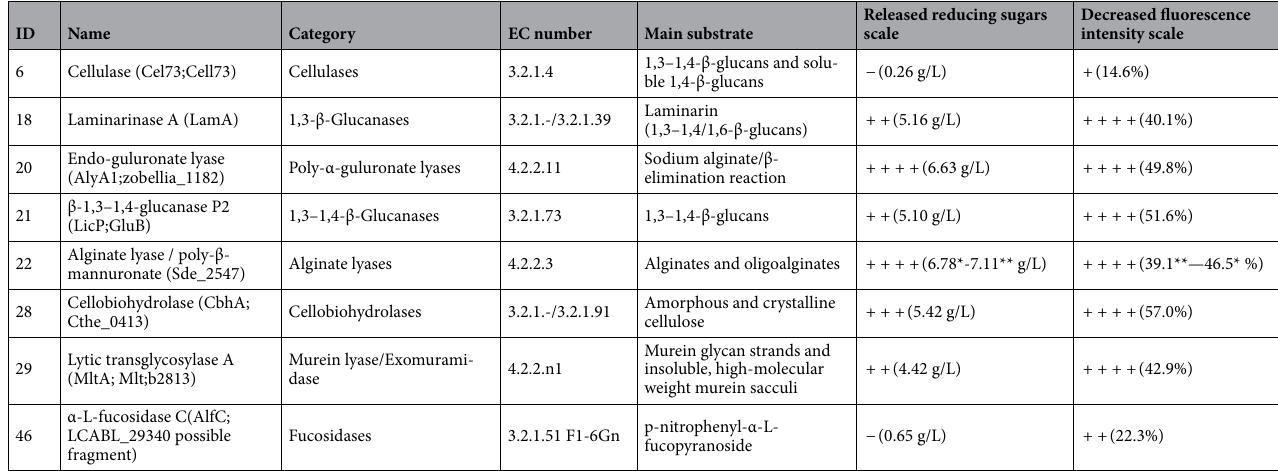
Table 1. Screening of the selected individual CAZymes for Laminaria digitata cell wall disruption. Each enzyme is presented with the project identification number (ID), name, category, EC number, main substrate and qualitative scales of reducing sugars and fluorescence intensity. The following qualitative scales were defined: (1) amount of released reducing sugars (g/L): − , 0.00 < 2.77; + , 2.77 < 3.99; + + , 3.99 < 5.20; + + + , 5.20 < 6.42, + + + + , > 6.42; (2) decrease of fluorescence intensity (%): − , 0.00 < 9.92; + , 9.92 < 20.0; + + , 20.0 < 29.9; + + + , 29.9 < 38.5; + + + + , > 38.5. The numeric values of released reducing sugars and decreased